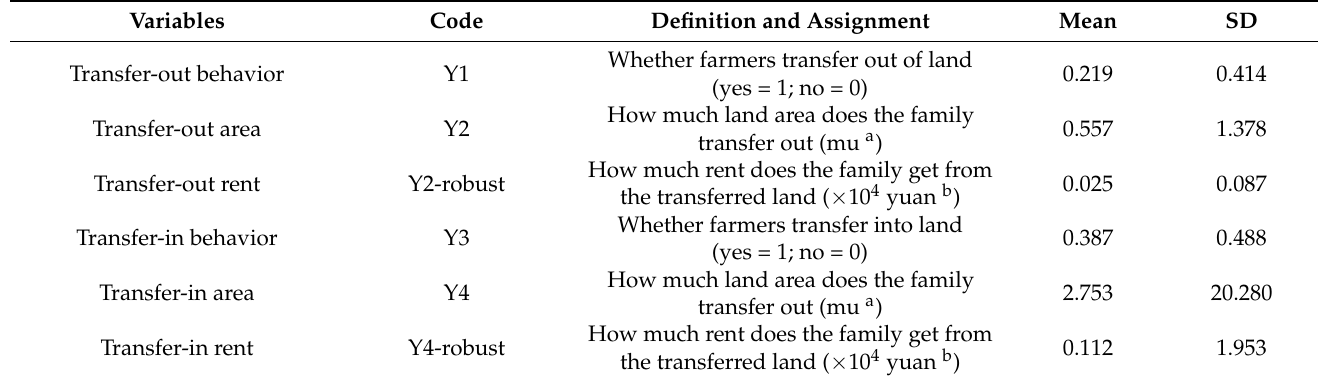
Table 2. Description of variable and descriptive